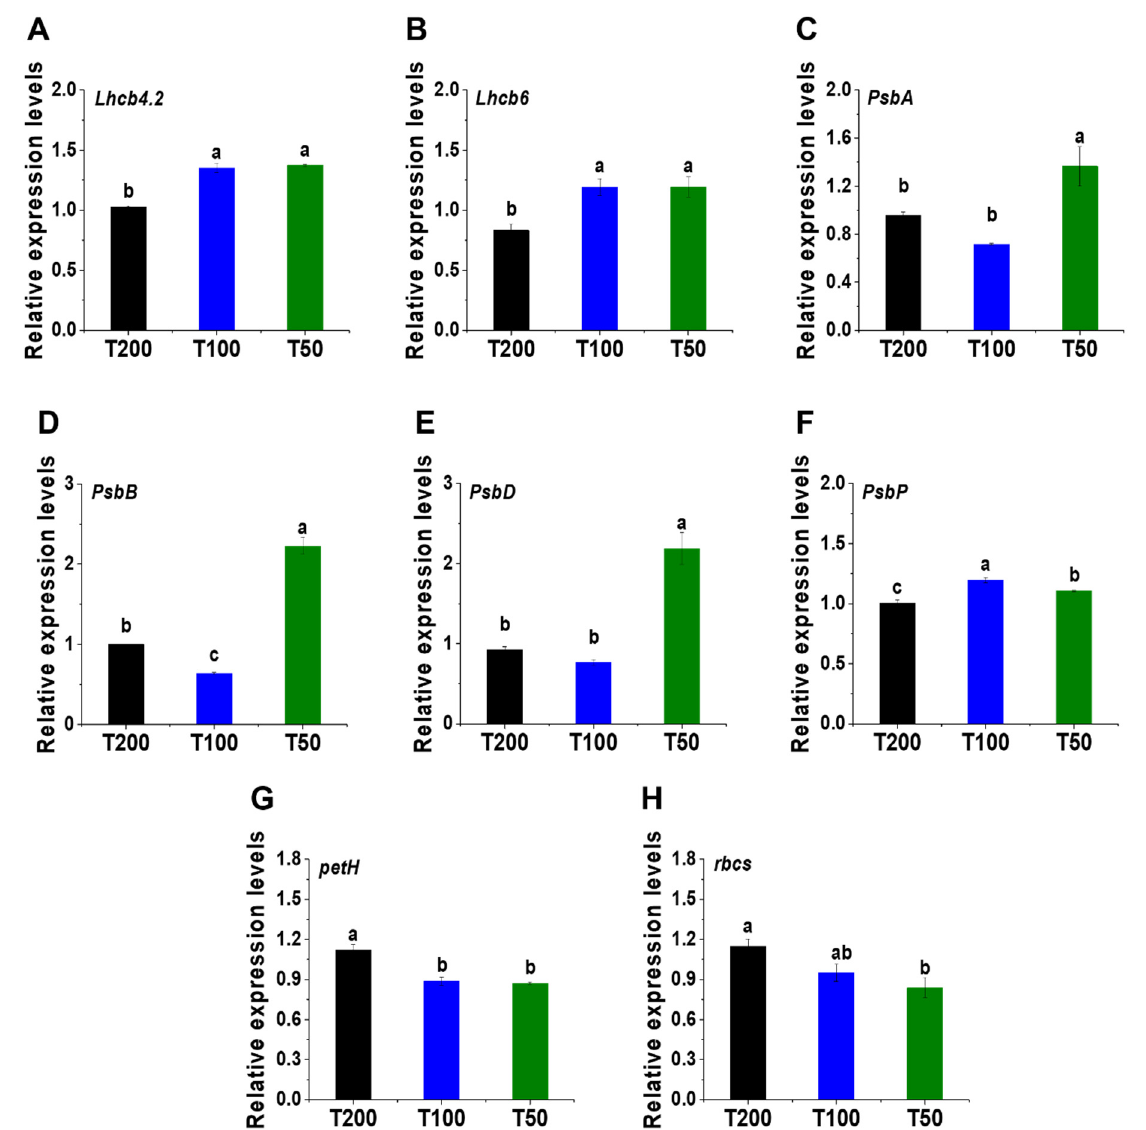
Figure 7. Effect of different light intensities on photosynthesis-related gene expression. The different light intensities make differential changes in the transcript levels of Lhcb4.2 ( A ), Lhcb6 ( B ), PsbA ( C ), PsbB ( D ), PsbD ( E ), PsbP ( F ), petH ( G ), and rbcs ( H ) genes. The error bar on each mean value column is ± SE. T200 represents the light intensity of 200 µ mol m − 2 s − 1 ; T100 represents the light intensity of 100 µ mol m − 2 s − 1 ; and T50 represents the light intensity of 50 µ mol m − 2 s − 1 .